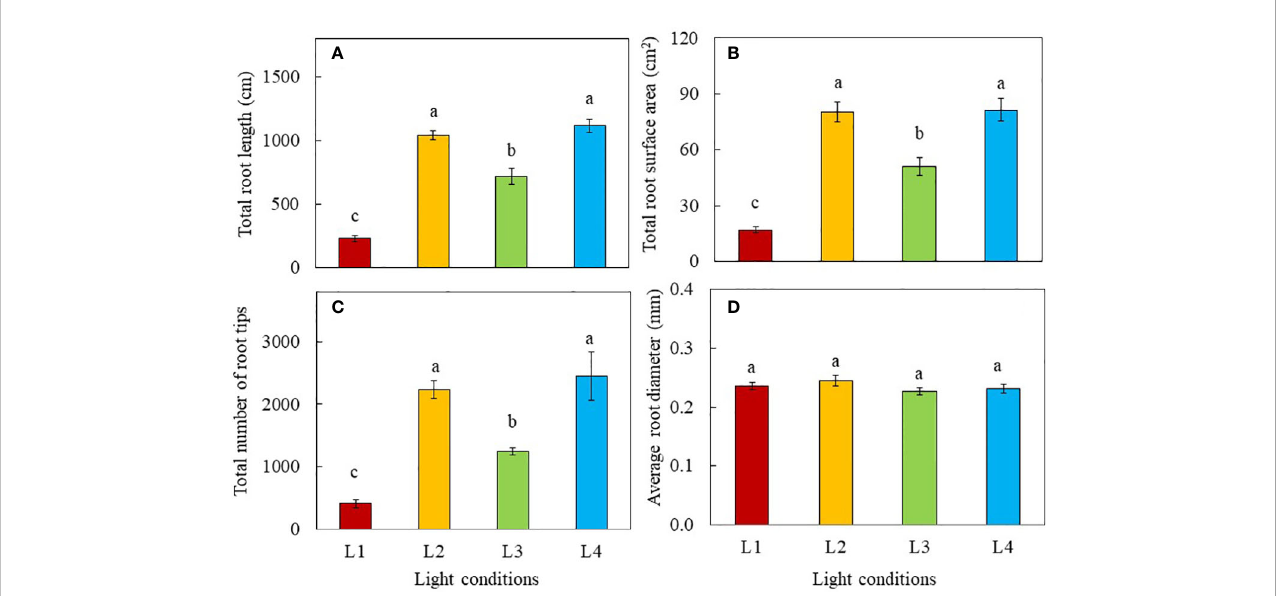
FIGURE 1 Total root length (A) , total root surface area (B) , total number of root tips (C) and average root diameter (D) of purslane grown under different light treatments for 8 days. Values are means ± standard errors. Means with different letters are statistically different ( p <0.05; n =5) as determined by Tukey ’ s multiple comparison test. L1 (240 µmol photon m -2 s -1 , 12 h, DLI = 10.368 mol m -2 day -1 ); L2 (320 µmol photon m -2 s -1 , 18 h, DLI = 20.736 mol m -2 day - 1 ); L3 (240 µmol photon m -2 s -1 , 24 h, DLI = 20.736 mol m -2 day -1 ); L4 (480 µmol photon m -2 s -1 , 12 h, DLI = 20.736 mol m -2 day -1